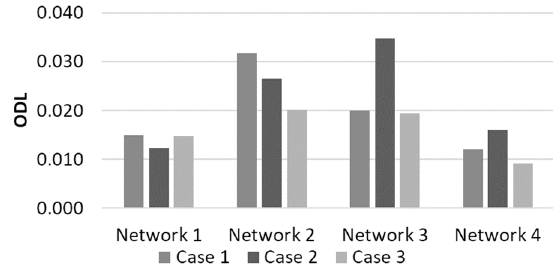
Figure 8. ODLs of four selected networks in three nodal elevation cases: plane elevation (Case 1), consistently increasing elevation (Case 2), and random elevation (Case 3). Network 1 with a pipe at all links (full network), Network 2 of BI = 0.2 and MC = 0.3, Network 3 of BI = 0.81 and MC = 0.29, and Network 4 of BI = 1.0 and MC = 0.